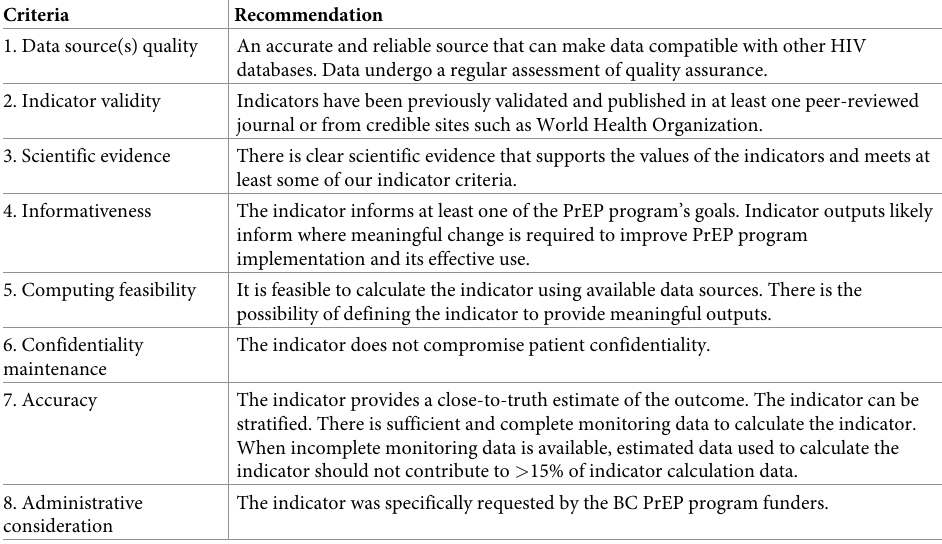
Table 1. Eight-selection criteria guide for choosing indicators for